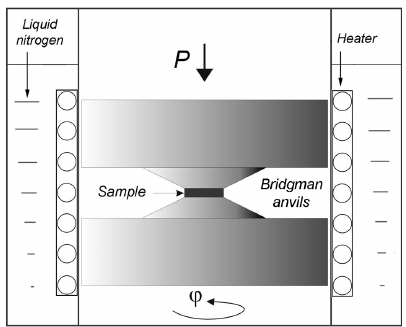
Figure 1. A schematic of experiment on deformation of a sample in Bridgman anvils, in the temperature range 80–573 К .